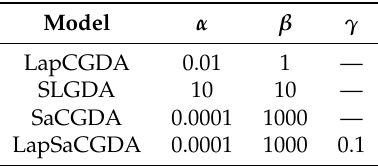
Figure 7. Classification accuracy (OA) w.r.t. different regularization parameters on the Salinas data: ( a ) parameter sensitivity analysis for regularization parameters α , β in SaCGDA; ( b ) parameter sensitivity analysis for regularization parameters β , γ in LapSaCGDA. Table 4. Optimal parameters settings for LapCGDA, SLGDA, SaCGDA and LapSaCGDA on the Salinas